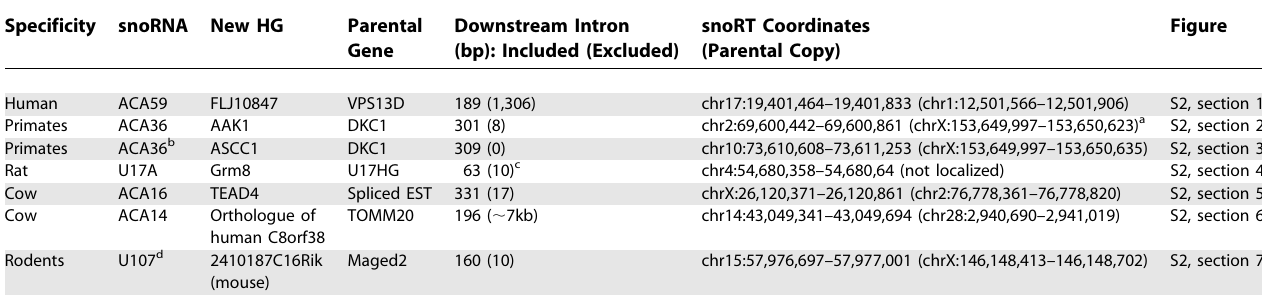
Table 2. Examples of Mammalian Type 2 snoRTs Specificity snoRNA New HG Parental